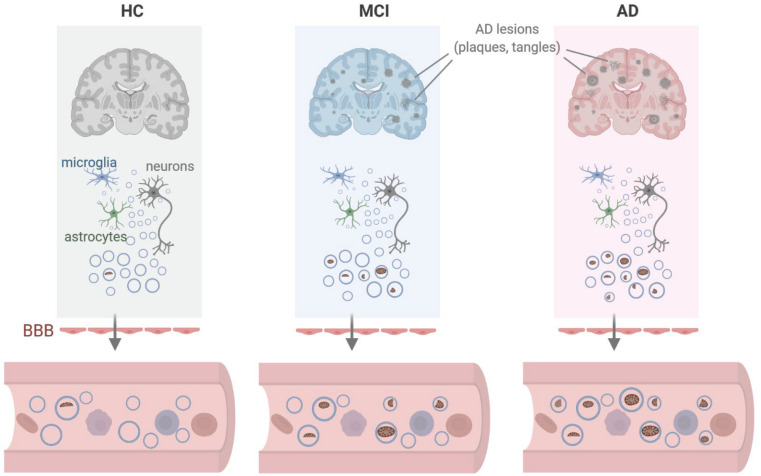
Model. We propose that in the vicinity of lesions (plaques, tangles) found in persons with mild cognitive impairment (MCI) or Alzheimer’s disease (AD), local damage to brain tissues can lead to the release of EVs containing dysfunctional or damaged mitochondria from cells including microglia, astrocytes, and neurons. As these EVs cross the blood-brain barrier (BBB), the mitochondrial contents (including mitochondrial RNA) present as EV cargo can be measured in peripheral blood. Created in BioRender.